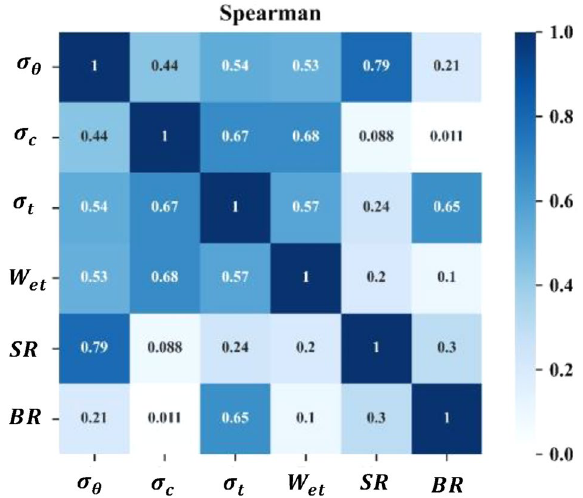
Figure 6. Heat map of the Pearson correlation coefficients of rockburst